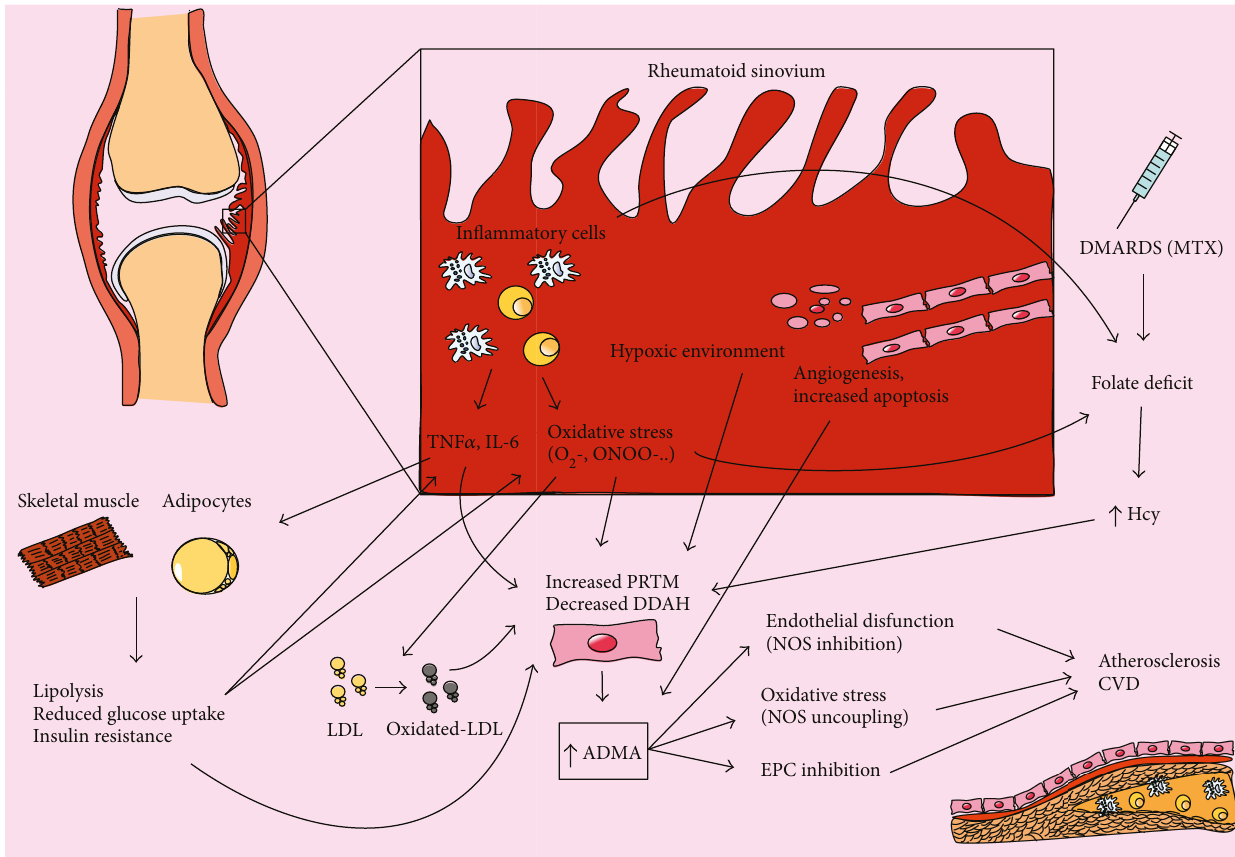
Figure 2: Mechanisms of ADMA-induced endothelial dysfunction in rheumatoid arthritis. The in fl ammatory microenvironment of the in fl amed synovia produces cytokines and reactive oxygen species which directly stimulate PRTM and inhibits DDAH in endothelial cells, increasing ADMA production. Cytokines in fl uence metabolically active tissues like skeletal muscle and adipocytes, inducing insulin resistance. This can generate a positive feedback loop, with an increased release of cytokines from macrophages and increased ADMA production in endothelial cells as well. The increased levels of oxidated lipoproteins, as a consequence of the oxidative stress linked to synovitis, furthermore contribute to ADMA synthesis, as well as the increased apoptosis of endothelial cells in in fl amed synovium. At last, folate de fi cit, related to the increased cellular turnover, to the oxidation of folate from reactive oxygen species and to the methotrexate treatment, induces an increased generation of homocysteine, which contributes to ADMA increase. ADMA increase can induce endothelial dysfunction, oxidative stress, and EPCs inhibition, conducing atherosclerosis development and cardiovascular complications. PRMT: protein arginine methyltransferases; DDAH: dimethylarginine dimethylaminohydrolase; NOS: nitric oxide synthase; ADMA: asymmetric dimethyl arginine; EPCs: endothelial progenitor cells; MTX: methotrexate; Hcy: homocysteine; CVD: cardiovascular